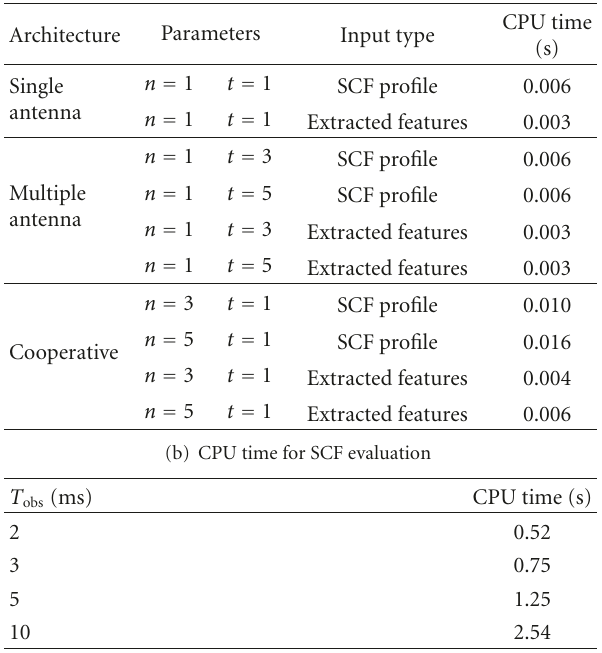
Table 5: computational complexity of the proposed processing chain.